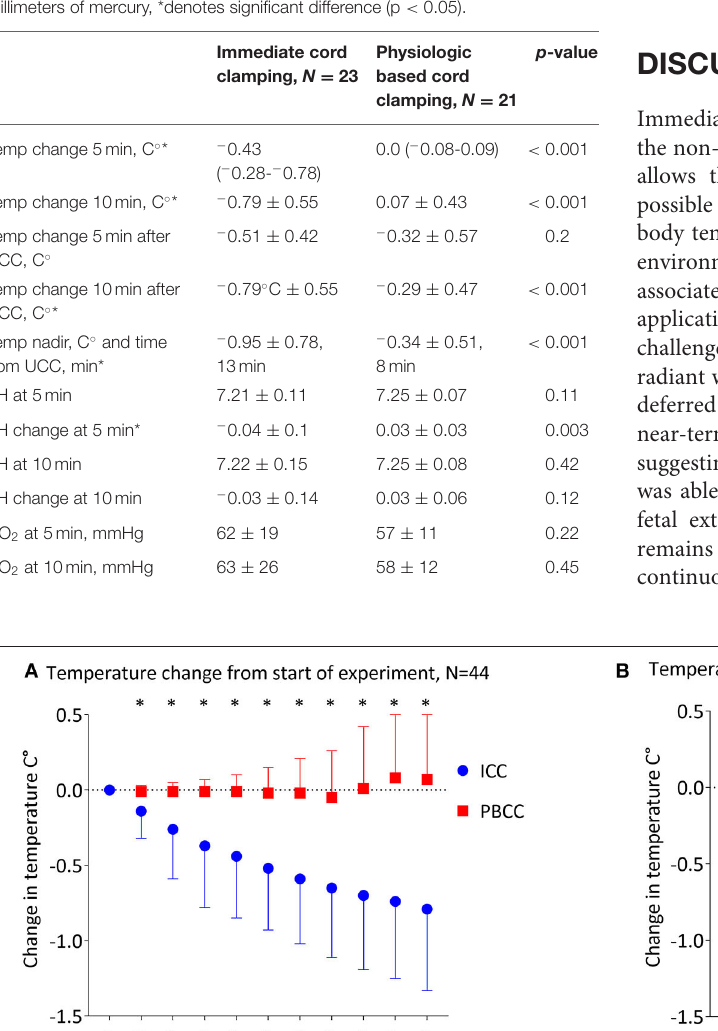
Frontiers in Pediatrics |